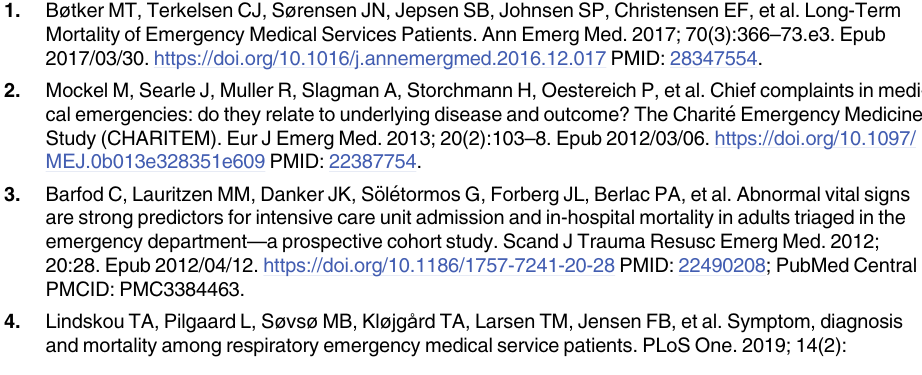
S5 Table. Characterization of the most frequent discharge diagnoses. S1 Dataset. Data set used for statistical